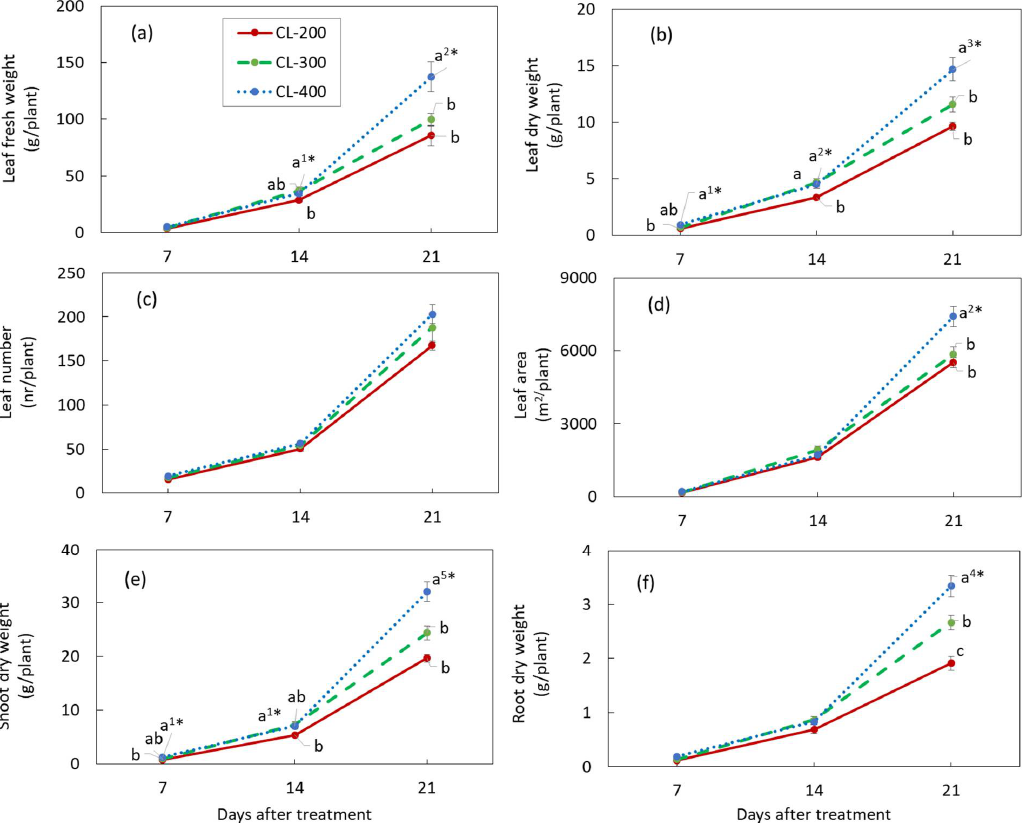
Figure 4. Leaf fresh ( a ) and dry weight ( b ), leaf numbers ( c ), leaf area ( d ), shoot dry weight ( e ), and root dry weight ( f ) of nasturtium grown under CL-200, CL-300, and CL-400 at 7, 14, and 21 days after treatment. CL-200, CL-300, and CL-400 represent the light period of 24 h per day with a light intensity at 200, 300, and 400 µmol m −2 s −1 , respectively. Values are the means ± SE ( n = 8). Different alphabet letters indicate significant differences between the treatments, the signs, 1 *, 2 *, 3 *, 4 *, or 5 * put after the alphabet ‘a’ at the largest mean for each parameter and each ‘days after treatment’, indicating that the probability of the ANOVA (the multiple mean comparison by Tukey) was p < 0.05, p < 0.01, p < 0.001, p < 1.0 × 10 −4 , or p < 1.0 × 10 −5 , respectively. The plant density during the 1st, 2nd, and 3rd weeks was 16.7, 11.1, and 5.6 plants m −2 , respectively.